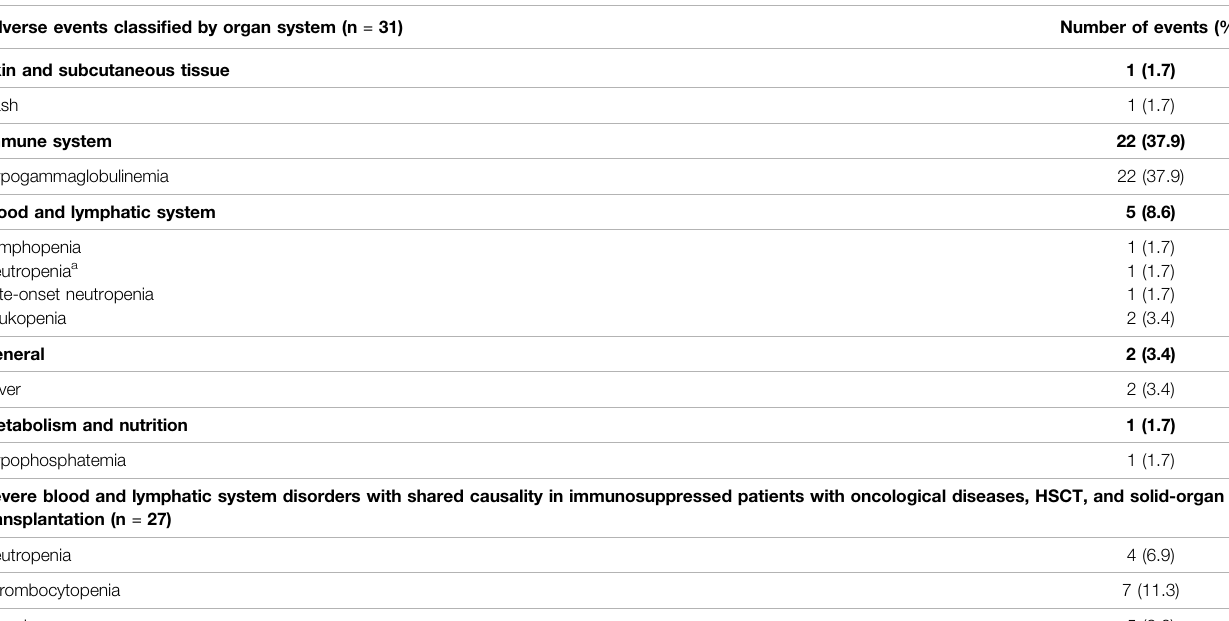
TABLE 7 | Delayed adverse reactions to rituximab according to the affected system (n (cid:1) 58). Adverse events classi fi ed by organ system (n =